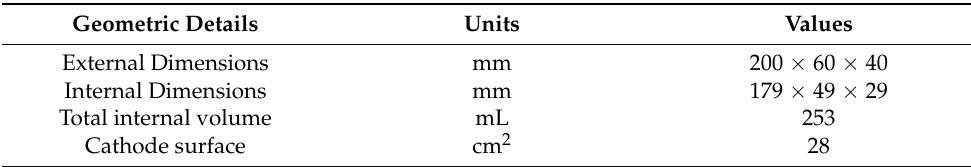
Table 2. Geometric data of a multi-electrode MFC.